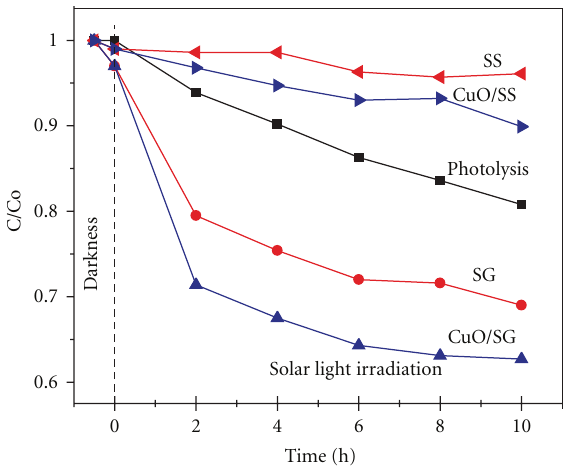
Figure 7: Photodegradation of indigo carmine under solar light irradiation using Sm 2 FeTaO 7 and CuO/Sm 2 FeTaO 7